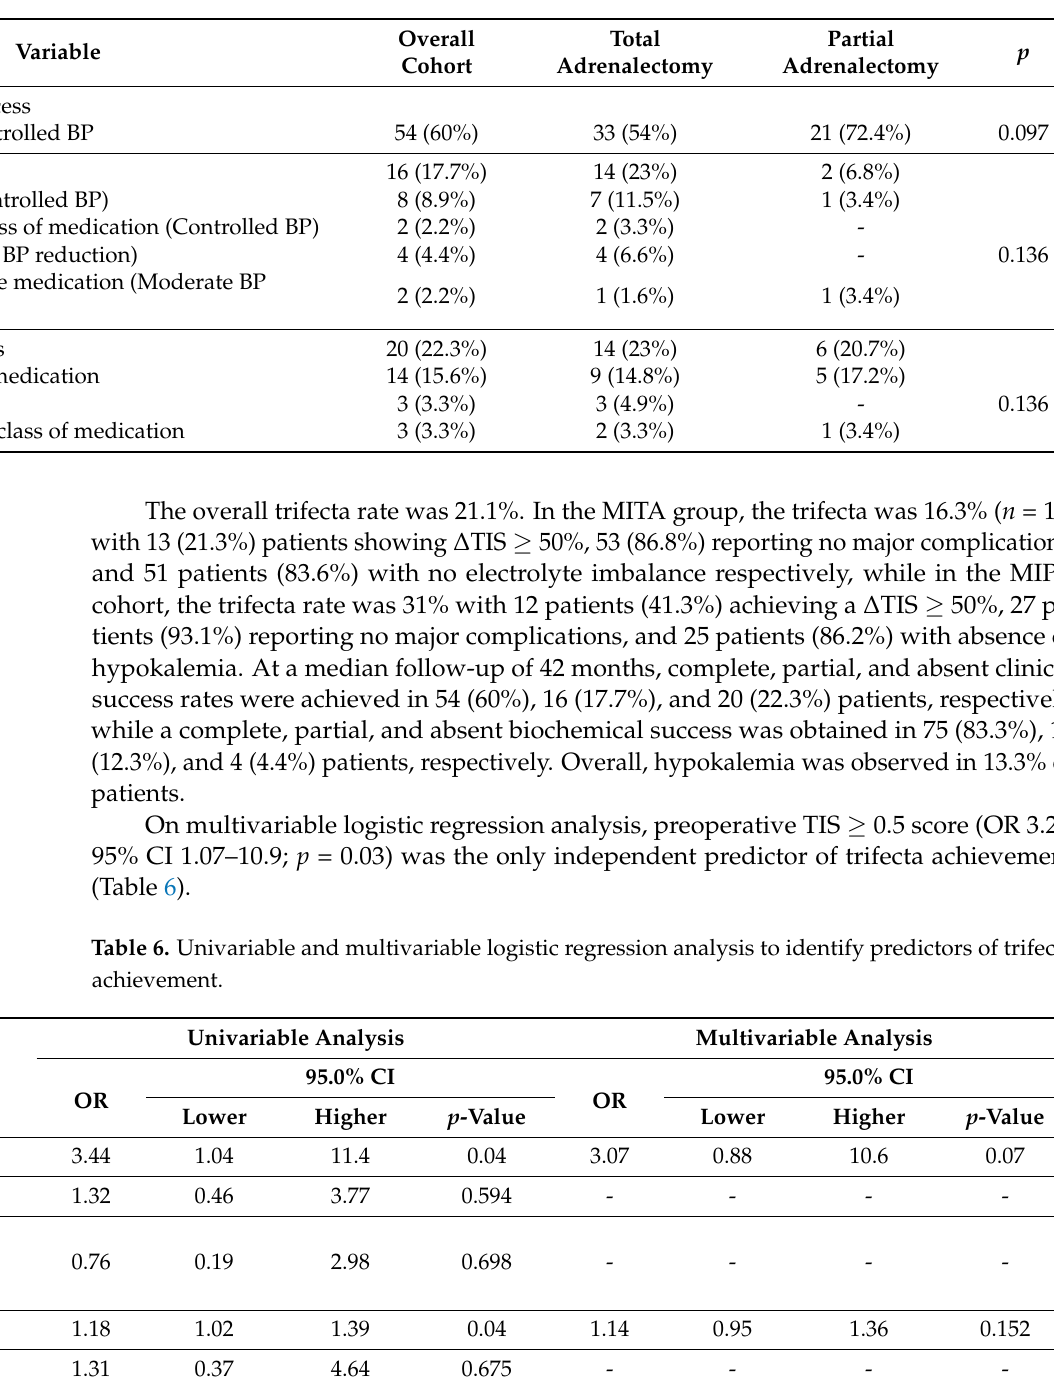
Table 5. Early and long-term functional outcomes according to PASO criteria.